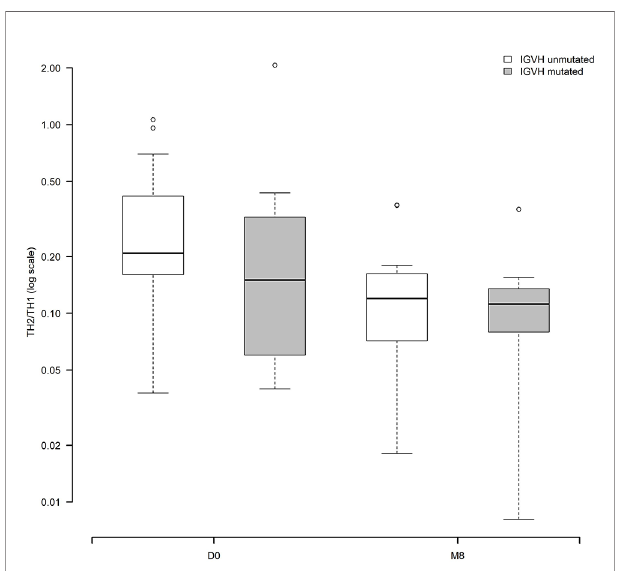
FIGURE 5 | Modulation of the Th2/Th1 ratio before and during ibrutinib treatment according to the IGHV status (30 patients with paired samples, 19 with unmutated IGHV, 11 with mutated IGHV). The Cochran-Mantel-Haenszel test showed that the decrease of the Th2/Th1 ratio over time was signi fi cant only among CLL cases with unmutated IGHV genes